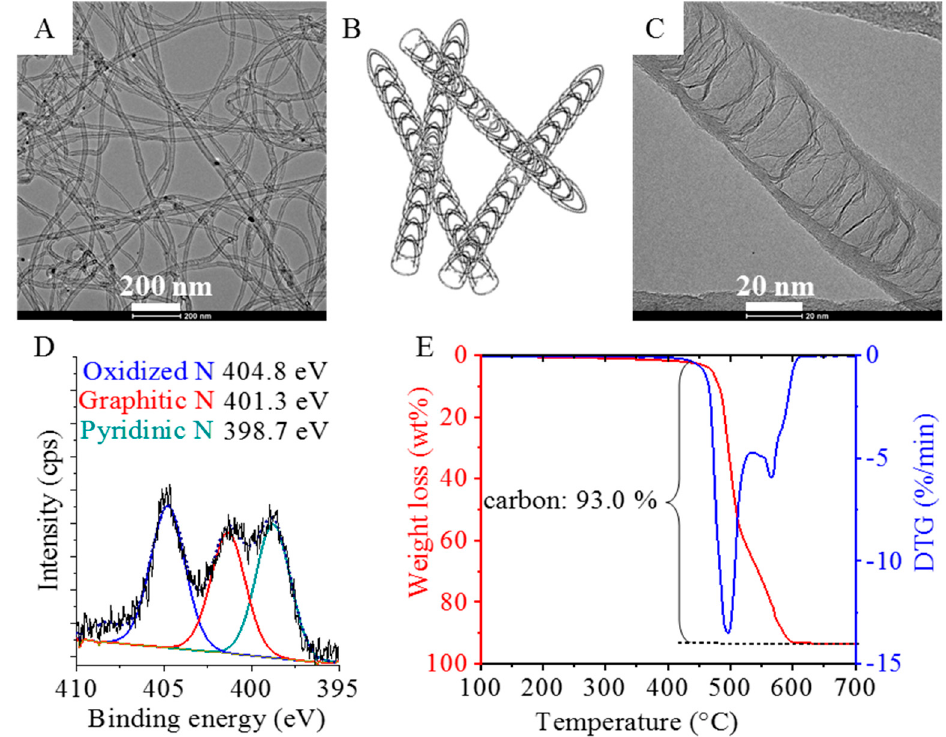
Figure 2. ( A ) TEM image, ( B ) schematic illustration, ( C ) HRTEM image, ( D ) XPS spectrum, and ( E ) TGA–DTG curves of the N-BCNT sample.